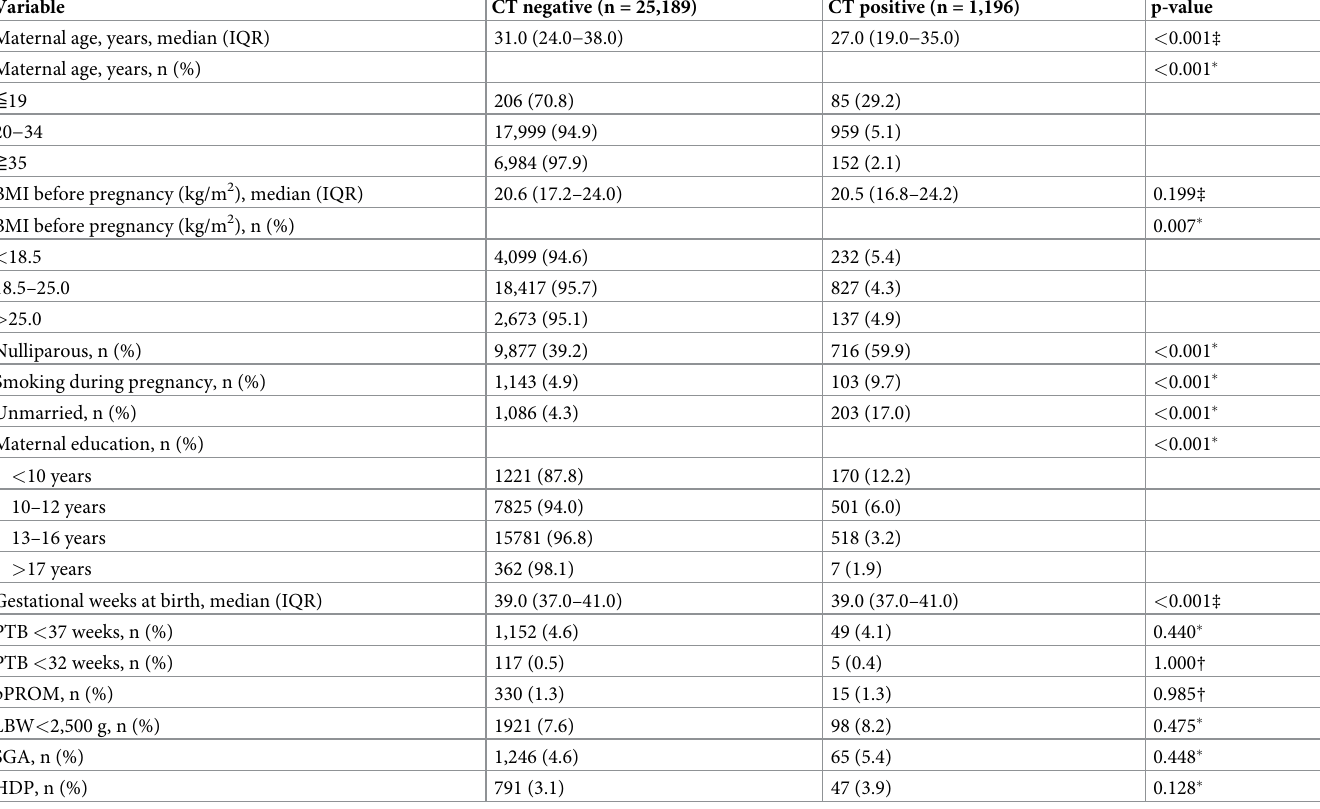
Table 1. Maternal medical and socioeconomic backgrounds and pregnancy outcomes (total